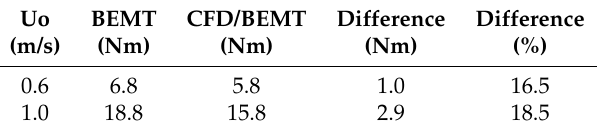
Figure 10. Electromagnetic Torque for ( a ) Uo = 0.6 m/s and ( b ) Uo = 1.0 m/s. Table 7. Average turbine electromagnetic